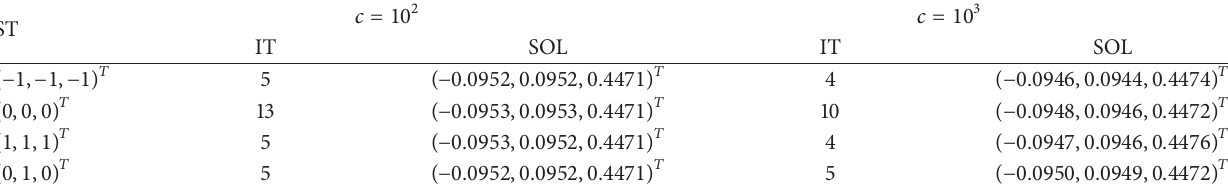
Table 3: Numerical results for Example 3 󸀠 .